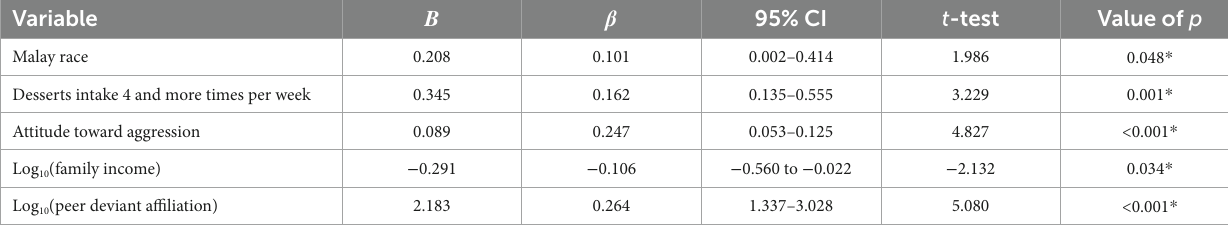
TABLE 4 Multivariate linear regression analysis summary for predictors of (adolescent aggression) 2 ( N = 463).